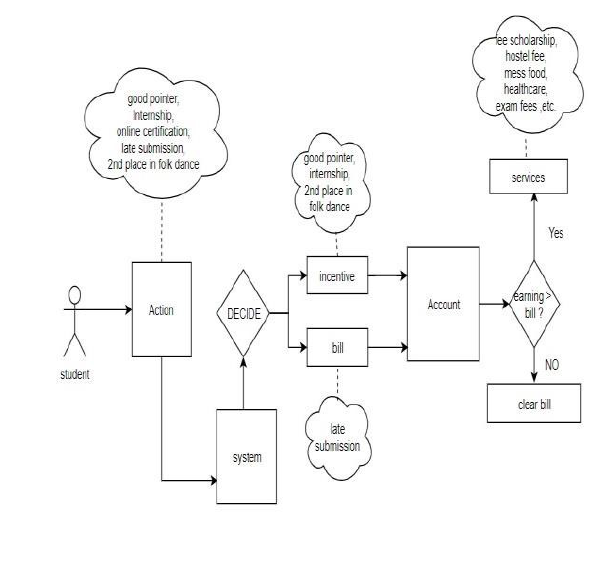
Figure 1. Overview of stick carrot model.